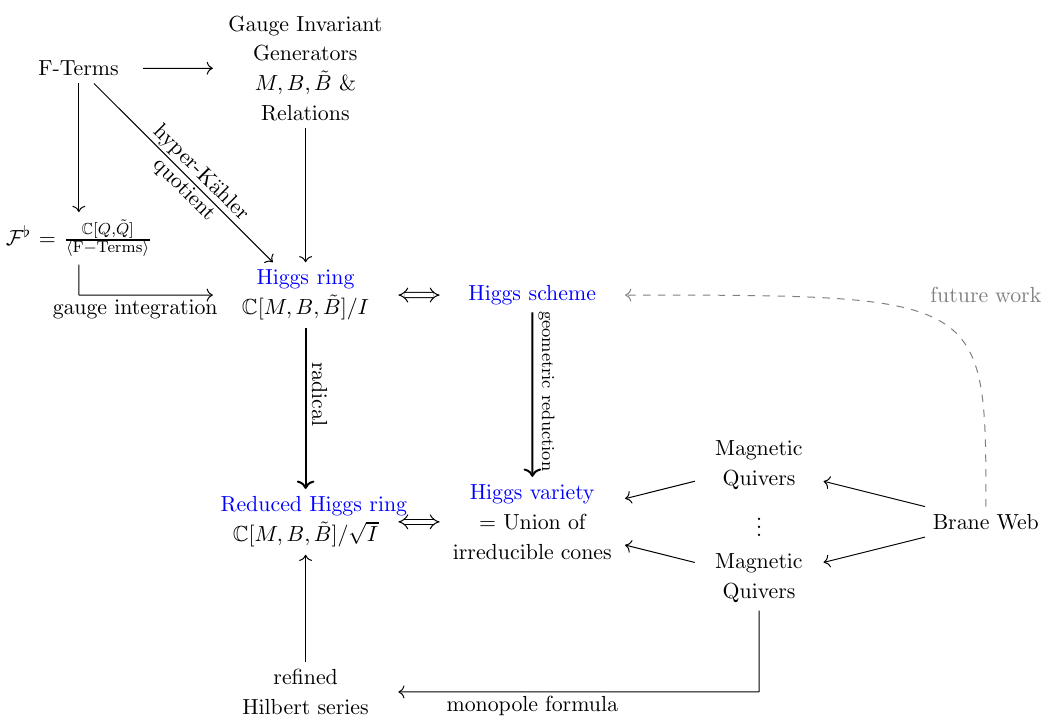
Figure 1 . Summary of the various incarnations of the Higgs branch. The second column contains the coordinate rings, the third column contains the geometric objects. In the second row, the ring contains nilpotent operators, it can be computed from the F-term relations through the hyper- K¨ahler quotient. Upon taking the radical (see appendix C), the third row contains no nilpotent operators. The associated Higgs branch is an algebraic variety, which is a symplectic singularity or union thereof. As such, it is described by magnetic quivers that can be read from the brane